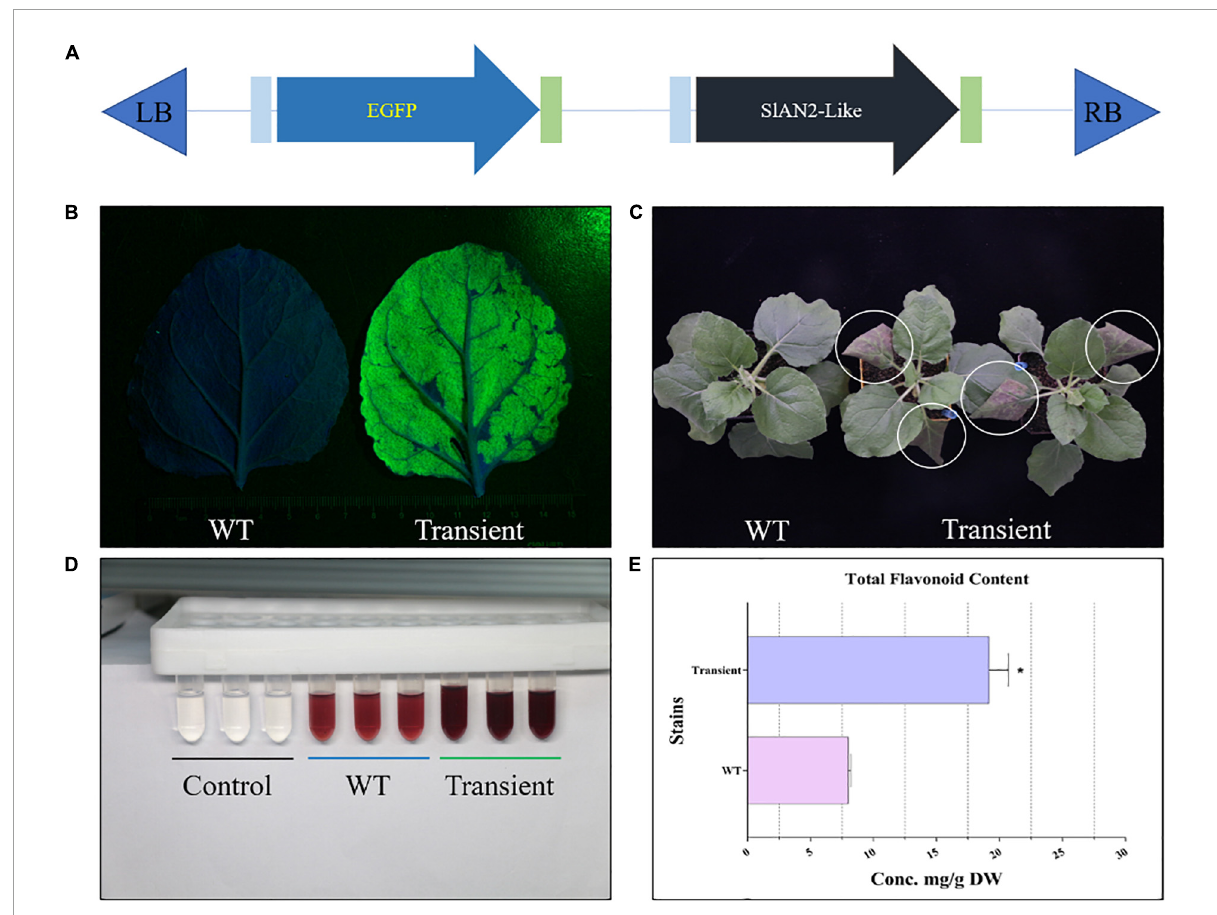
FIGURE3 Pre-test of the novel E-platform. (A) Schematic diagram of the simple “test unit.” (B) GFP fluorescence of the leaves under blue excitation light (approx. 470 nm). (C) Phenotypes of WT and infiltrated N. benthamiana . (D,E) Color reaction and total flavonoid content determination in WT and infiltrated N . benthamiana . “Transient” represents infiltrated N . benthamiana . The error bars represent the standard deviations from three independent experiments. The asterisks indicate significant differences (* P <